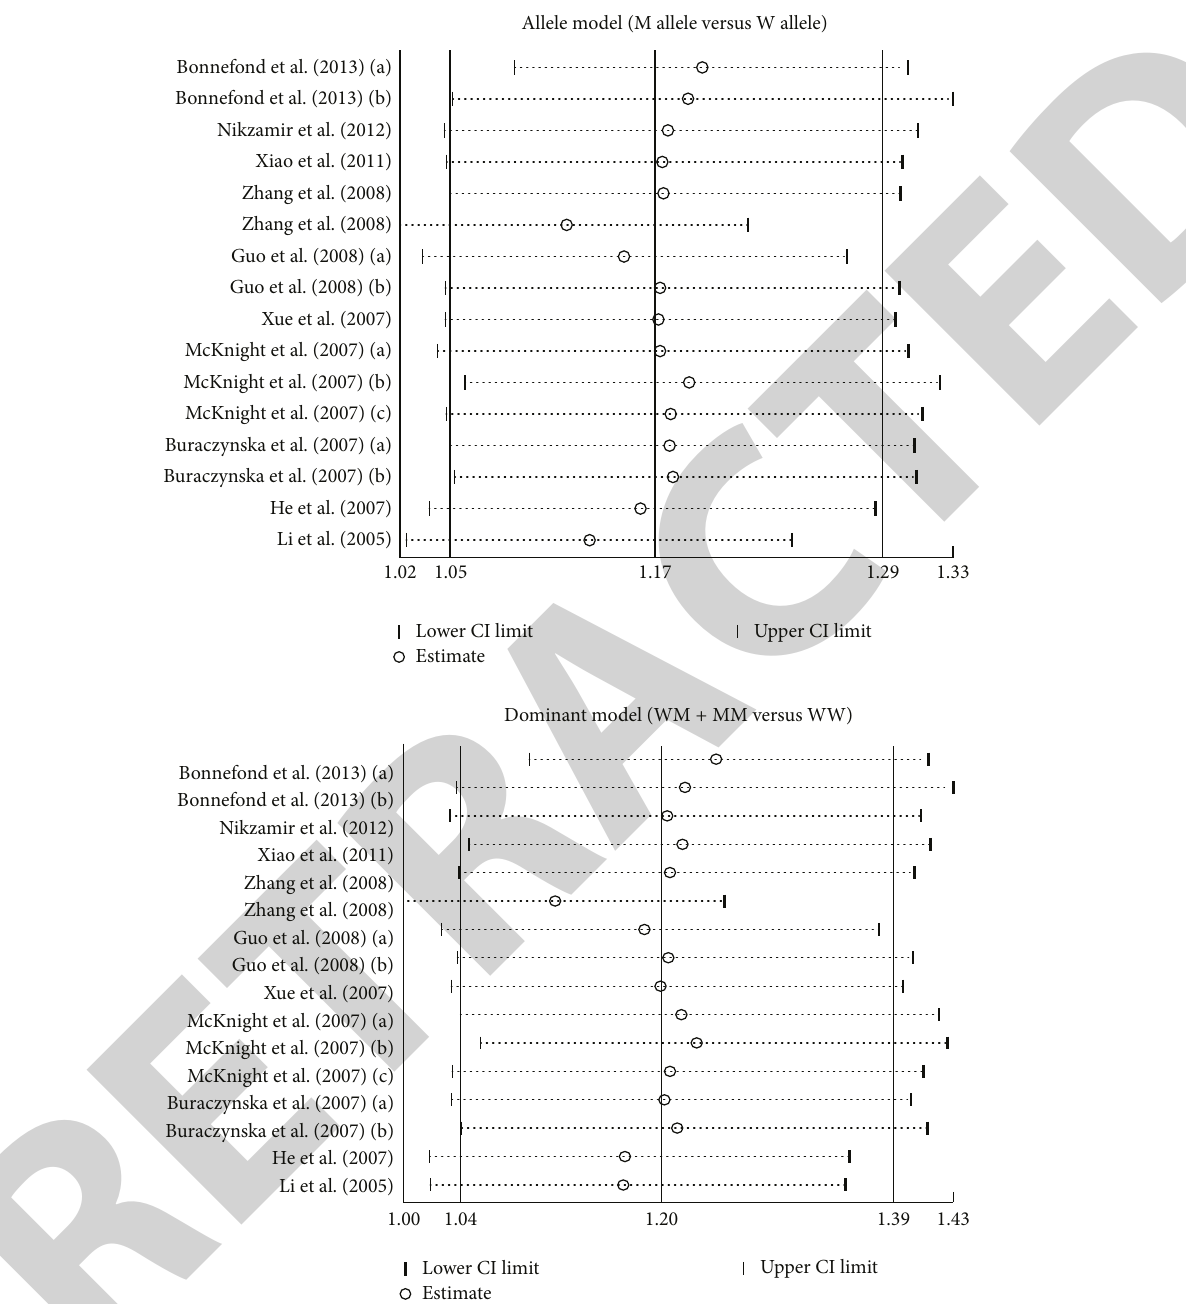
Figure 5: Sensitivity analysis of the summary odds ratio coefficients on the relationships of VEGF genetic polymorphisms with the risk of diabetic nephropathy in patients with diabetes mellitus under the allele and dominant